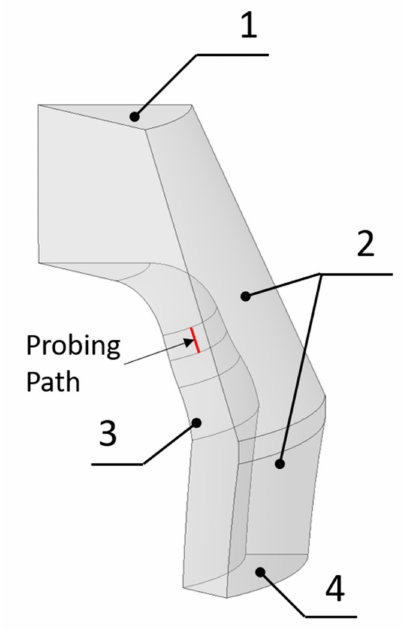
Figure 5. Azimuthal portion of the full domain used for the electric field simulation: (1) top boundary, (2) MIG’s anode surface, (3) MIG’s cathode surface, and (4) bottom boundary. The red line marks the probing path used for the generation of the plot in Figure